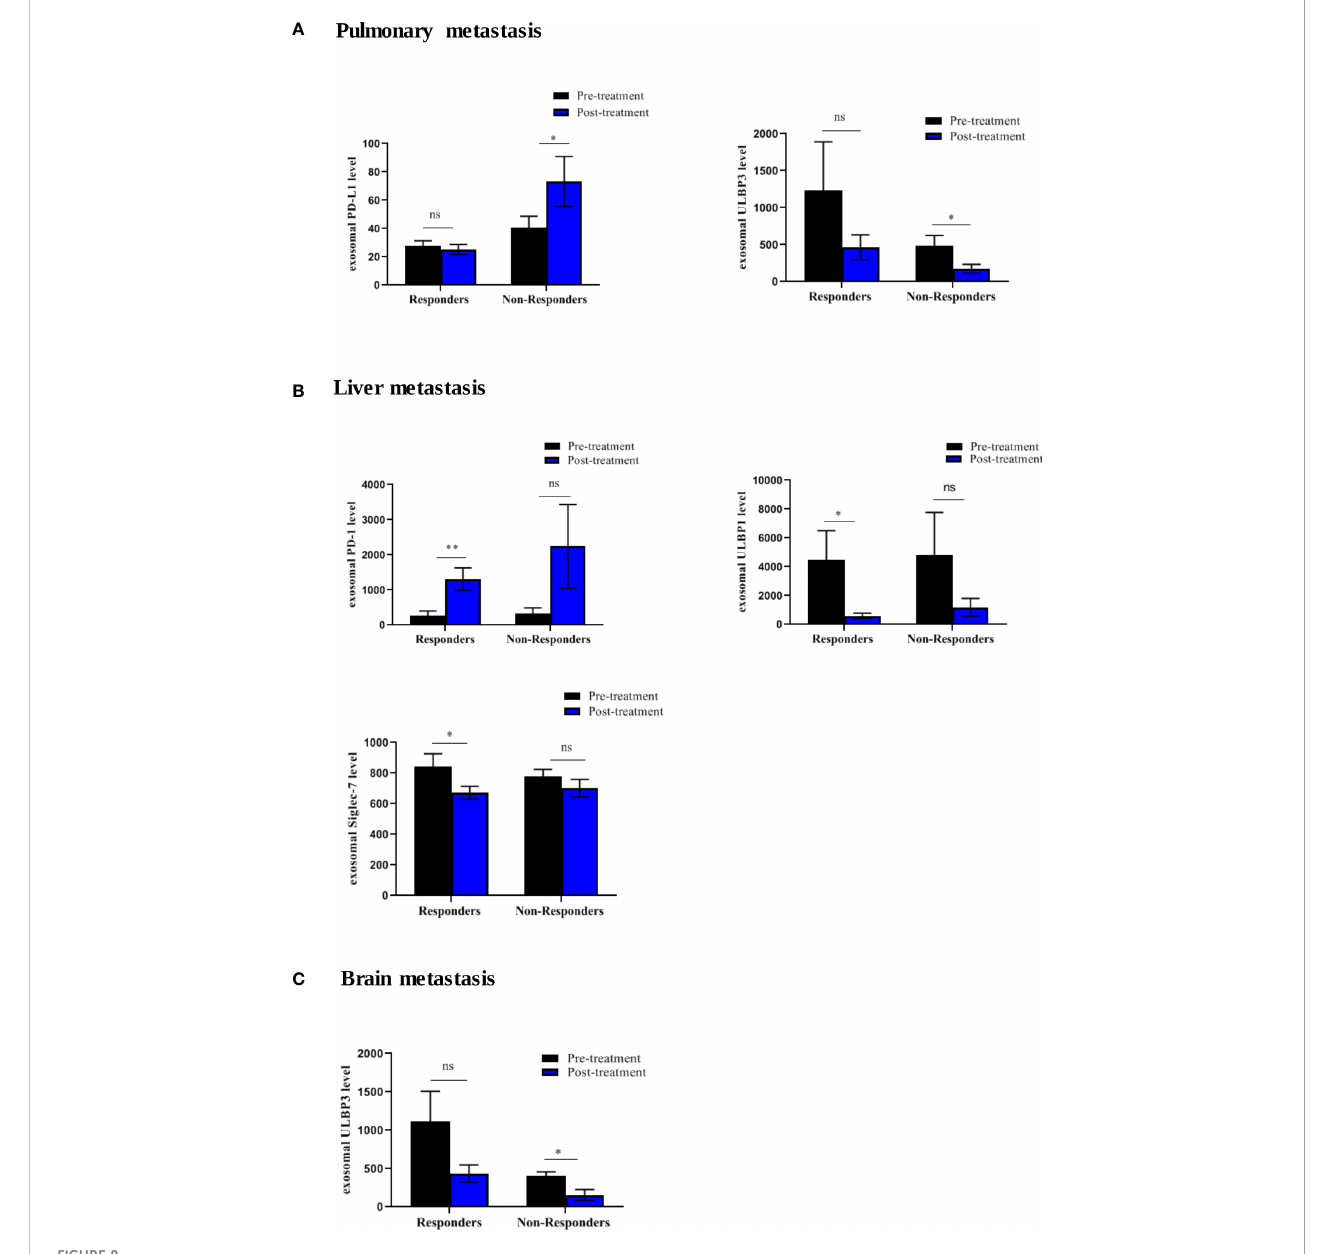
FIGURE 8 Differential expression of exosomal immune-oncology markers strati fi ed according to metastasis in NSCLC patients. (A) Signi fi cant upregulation of PD-L1 (p=0.0262) and downregulation of ULBP3 (p=0.0286) in non-responding patients with pulmonary metastasis. (B) Signi fi cant upregulation of PD-1 (p=0.0070) and downregulation of ULBP-1(p=0.0137), Siglec-7 (p=0.0371) in responding patient without liver metastasis. (C) Signi fi cant downregulation of ULBP3 (p=0.0317) in non-responding patients without brain metastasis. * signi fi cant; ** moderate signi fi cant; ns non-signi fi